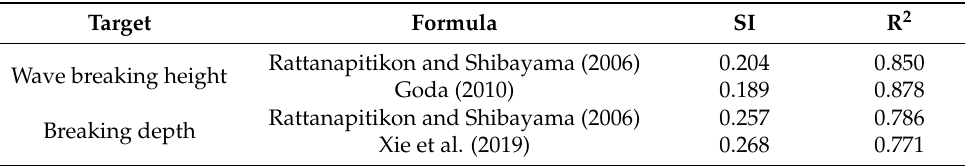
Table 2. Results of error